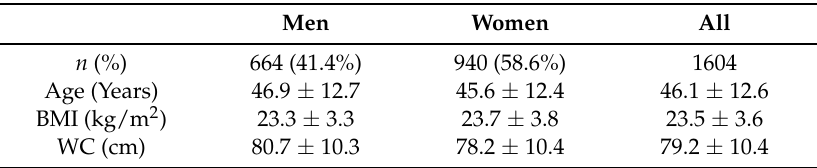
Table 1. Physical characteristics of the participants.